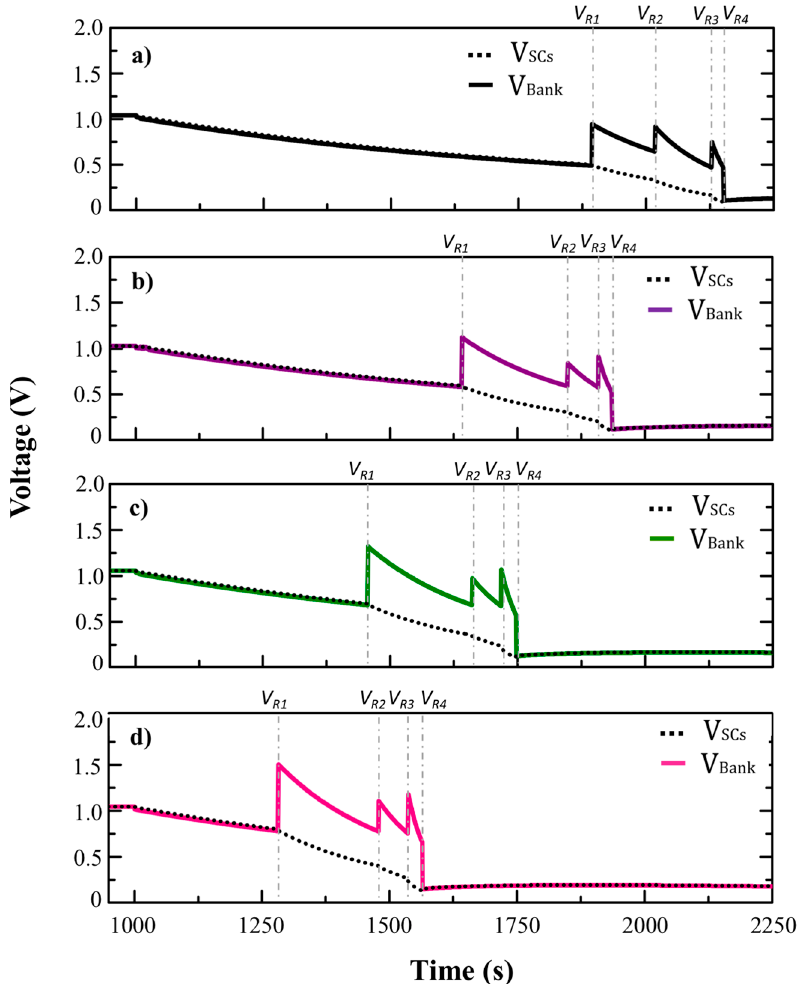
Figure 9. Programmed discharge profiles recorded by the bank voltage. ( a ) Rtn 1 ; ( b ) Rtn 2 ; ( c ) Rtn 3 ; and ( d ) Rtn 4